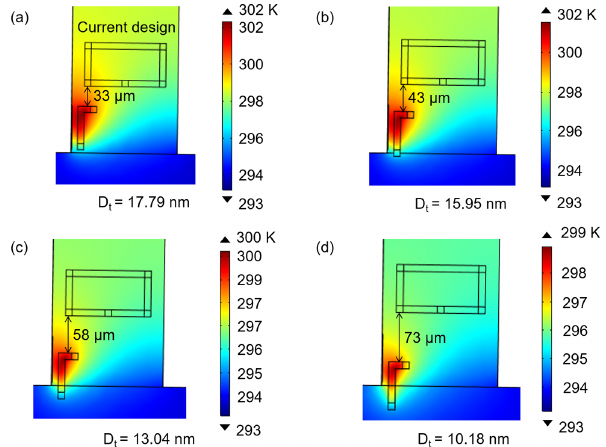
Figure 5. FEM for a thermally actuated cantilever sensor based on the current design (a) and with HR shifted away (b, c, d) from the WB towards the cantilever